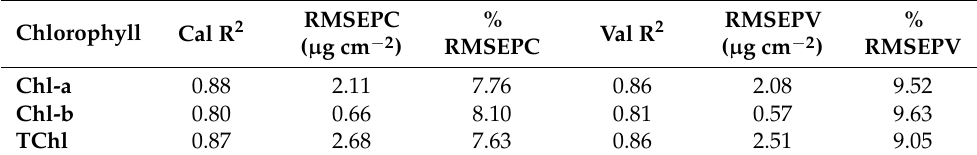
Table 2. The Chl-a, Chl-b, and TChl estimation based on PLSR model.